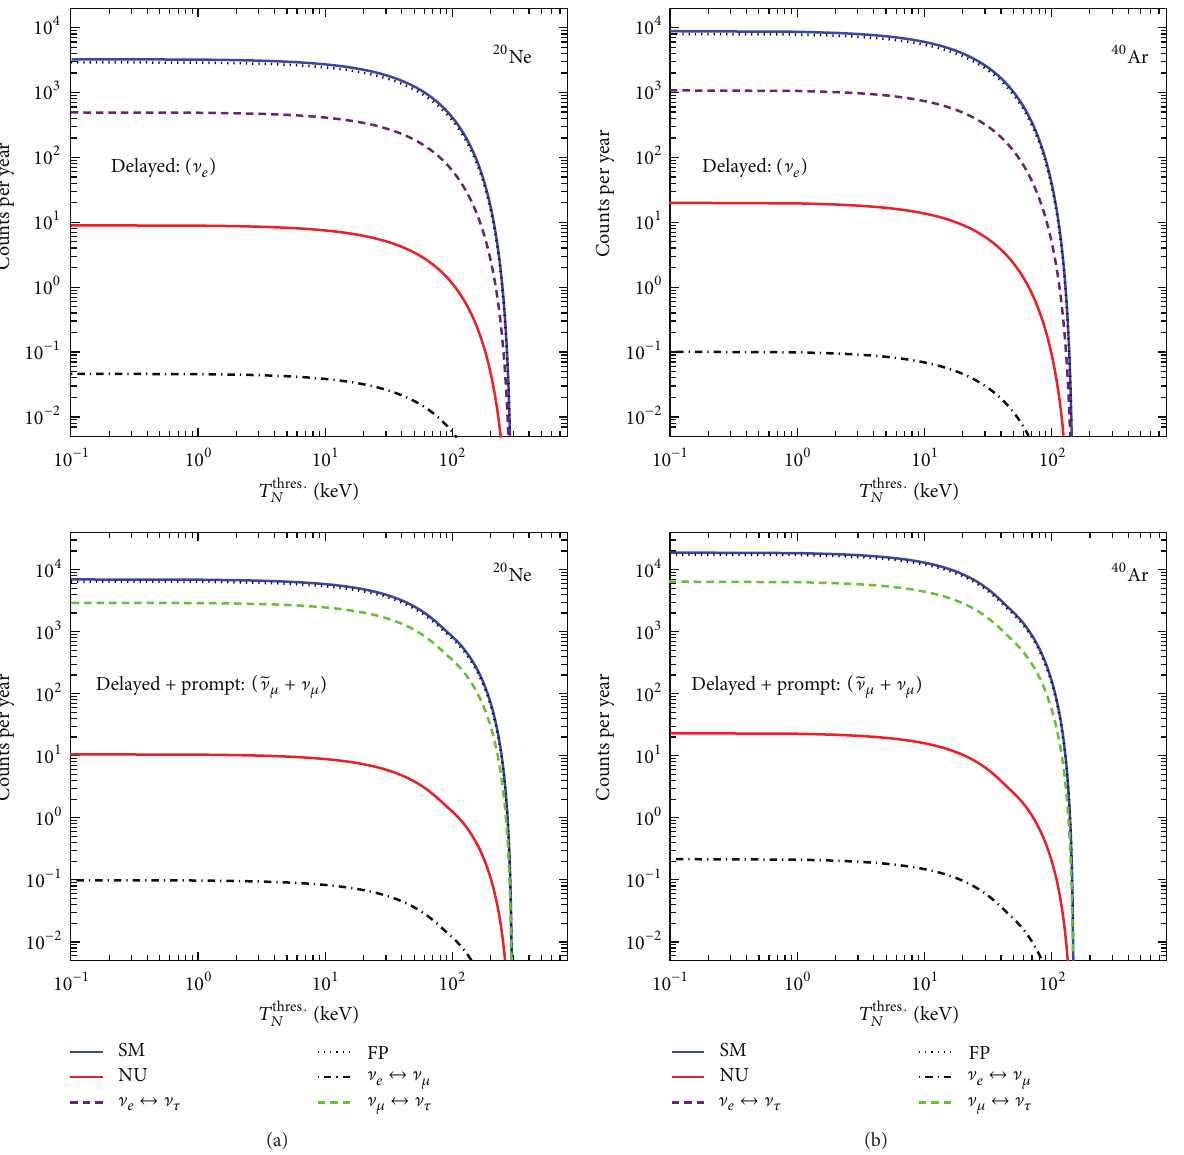
Figure 8: The expected nonstandard neutrino scattering events over the recoil energy threshold at the COHERENT detector, filled with (a) 391 kg of liquid 20 Ne and (b) 456 kg of liquid 40 Ar, both located at a distance of 20m ( Φ ] efficient detector and negligible neutrino oscillation effects are